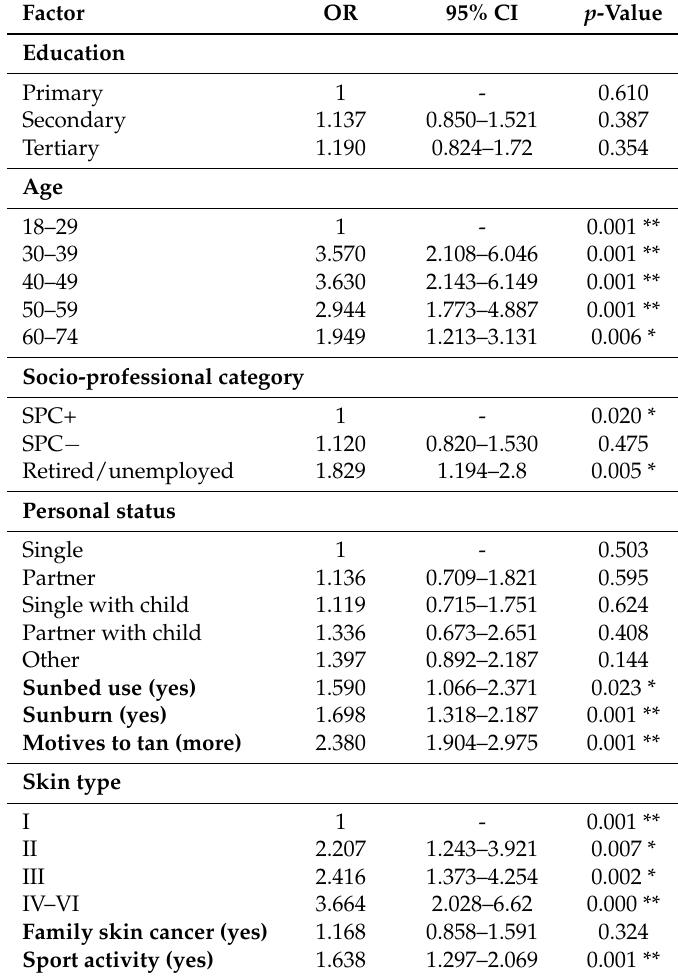
Table 4. Results of the linear regression analysis on sun exposure